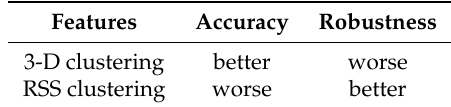
Table 1. Feature comparisons for 3D clustering and RSS